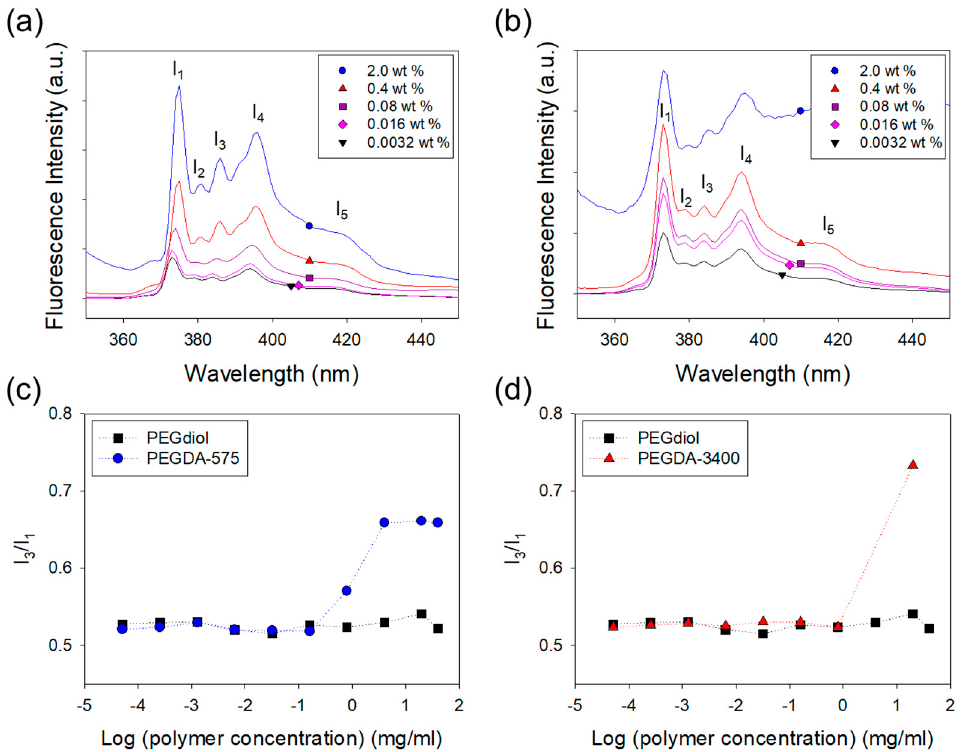
Figure 2. Fluorescence emission spectra of pyrene loaded in the ( a ) PEGDA-575 solution, ( b ) PEGDA-3400 solution were captured at various polymer concentrations. The ratio of third-to-first vibrational fine structure ( I 3 / I 1 ) in PEGDA increased while that of PEGdiol kept constant. The increase of I 3 / I 1 ratio of pyrene in the presence of polymer indicated that polymers formed aggregation. In ( c ) and ( d ), ● represents the solution of PEGDA-575, ▲ the solution of PEGDA-3400 and ■ the solution of PEGdiol.